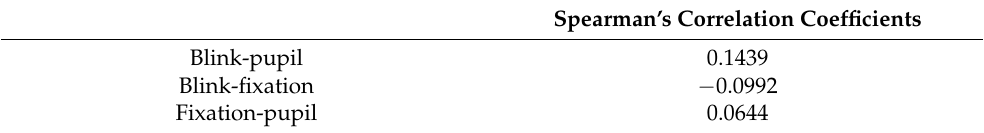
Table 1. Spearman’s correlation coefficients with respect to the pairs of the three